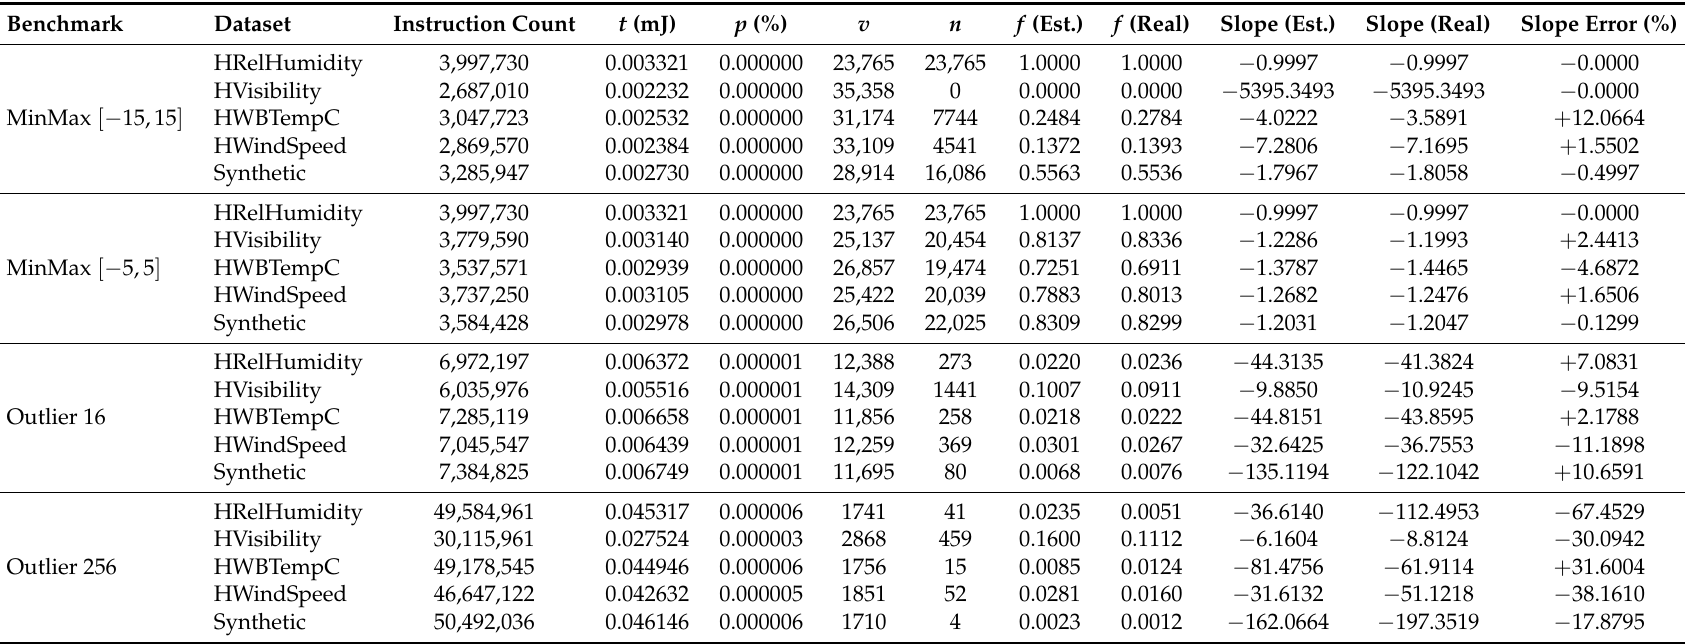
Table A6. Raspberry Pi 3 energy consumption results in fog-prone